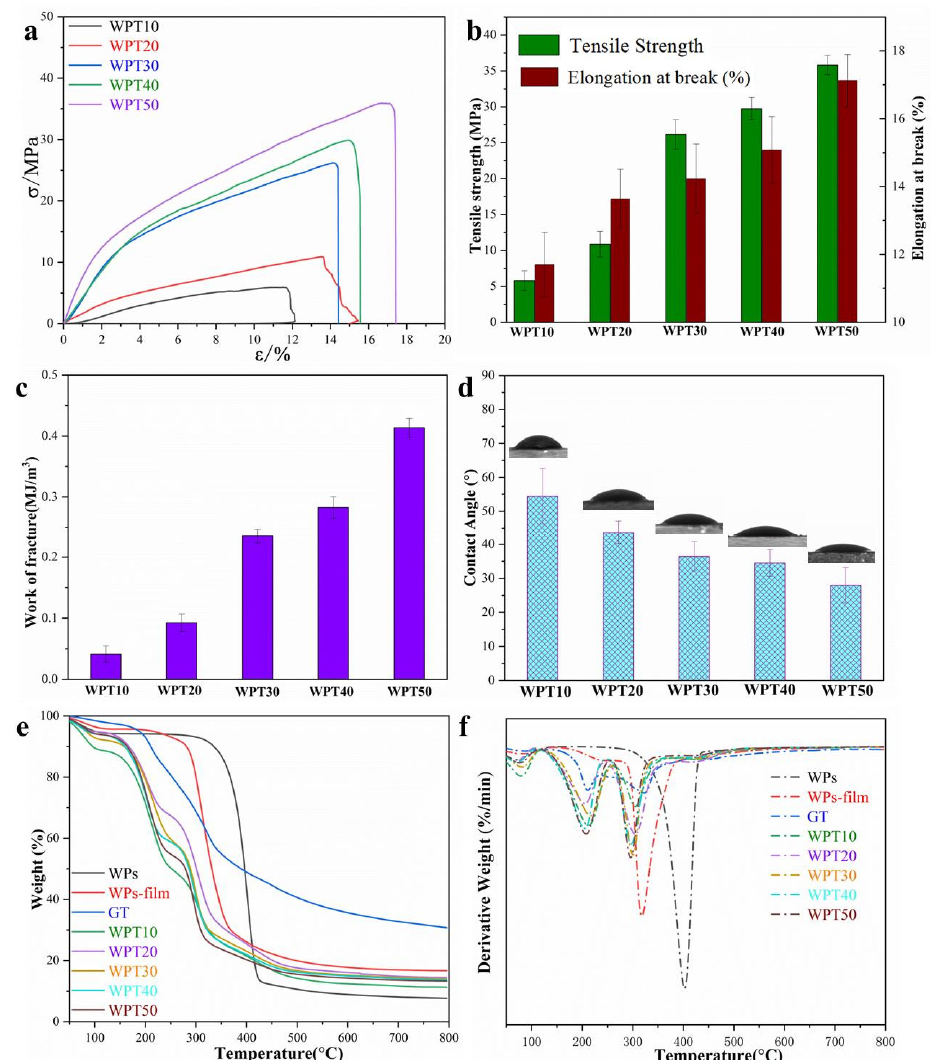
Figure 6. ( a ) Stress–strain profiles; ( b ) tensile strength and elongation at break; ( c ) work of fracture; ( d ) water contact angle of WPT10, WPT20, WPT30, WPT40 and WPT50; ( e ) TG; and ( f ) DTG of WPs, GT, WPs-film, WPT10, WPT20, WPT30, WPT40 and WPT50.